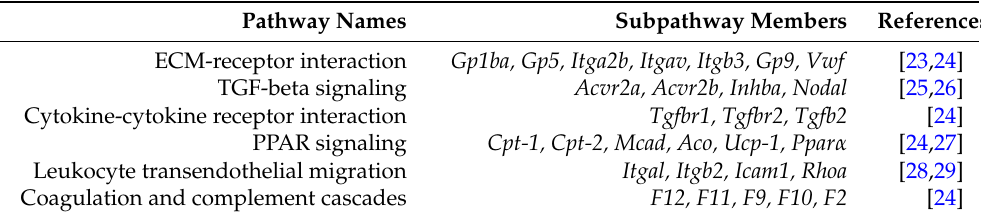
Table 1. Pathway terms detected by PerSubs along with the detected subpathway